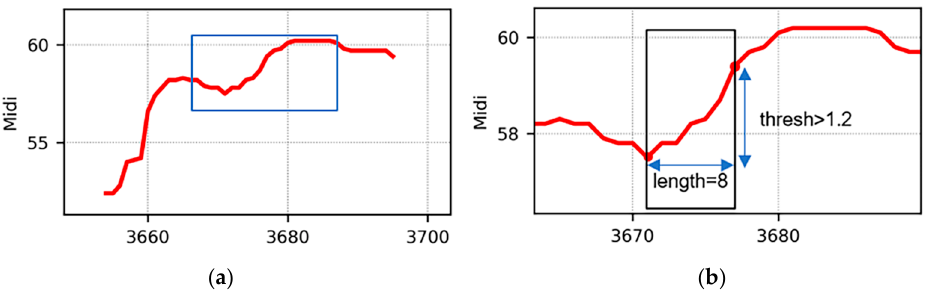
Figure 7. Segmentation of notes using stability region: ( a ) is a fragment of the first song in the dataset “Cmedia” from singing transcription task; ( b ) shows the detailed data in the blue box, where the black box represents the sliding window and the threshold in the figure is the optimal pitch difference of the melody segmentation.